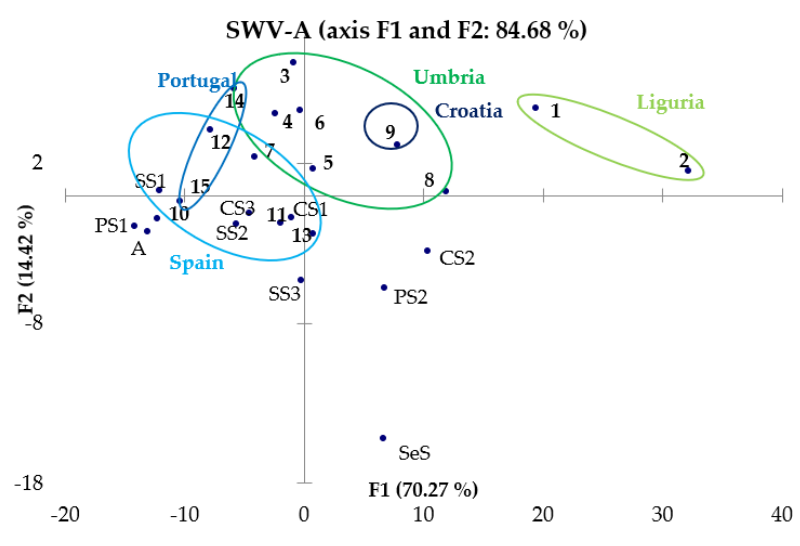
Figure 8. PCA of SWV-A data.